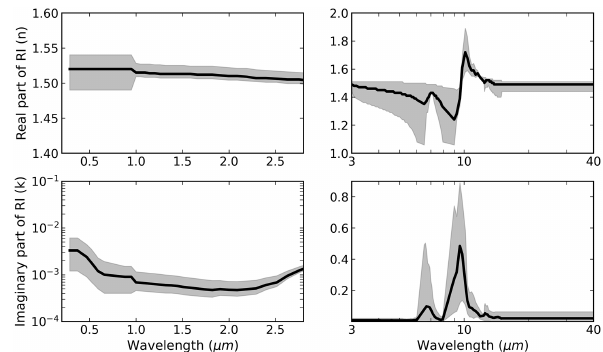
Figure 2. The SW and LW spectral refractive indices (RI) used in this study obtained from Di Biagio et al. (2017, 2019) and Balka- nski et al. (2007). The black curves represent the mean RI which indicates the mean absorptive dust. The grey shading represents the upper and lower limits indicating more absorptive and less absorp- tive dust,